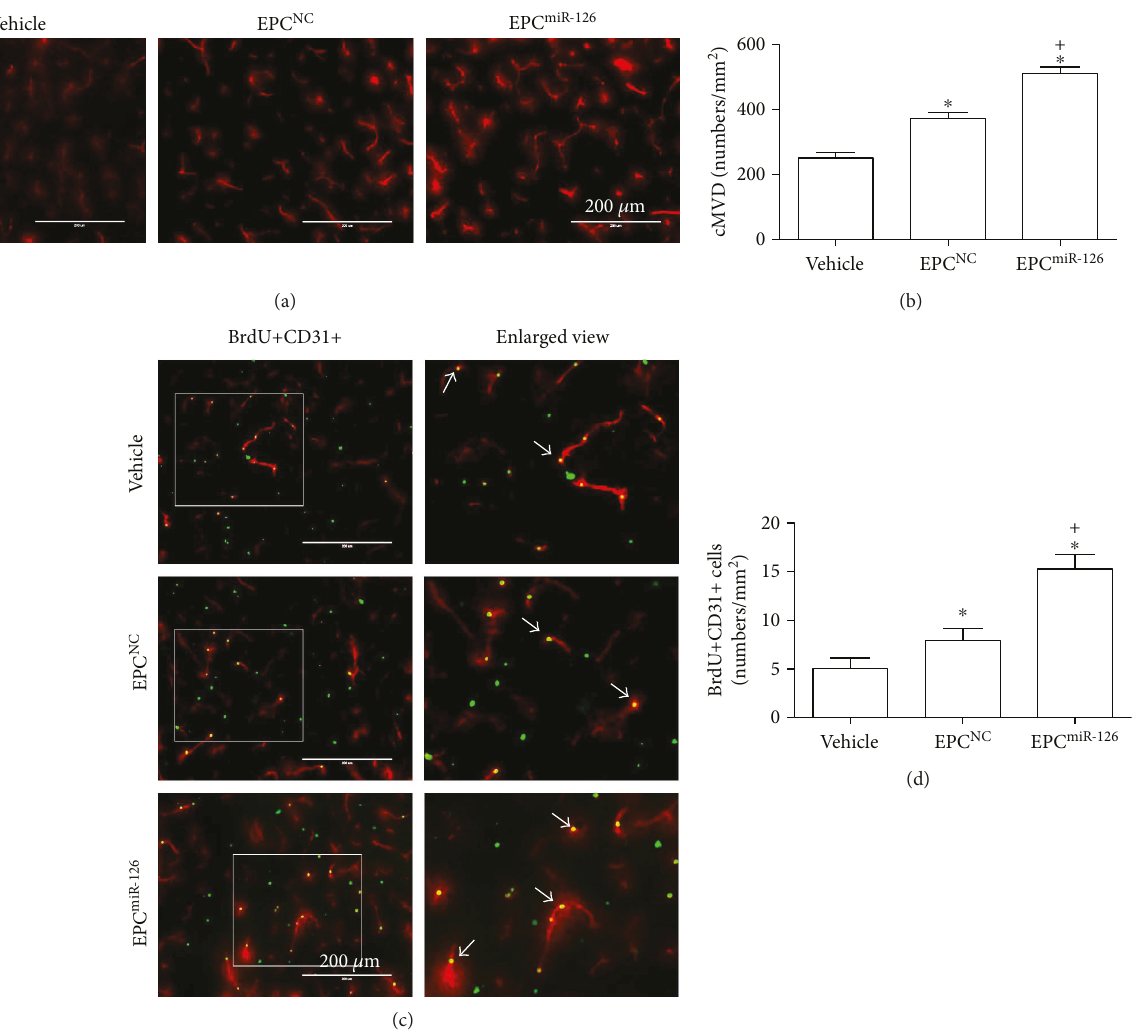
Figure 6: miR-126 priming enhances the e ffi cacy of EPCs in increasing cMVD and angiogenesis in the peri-infarct area of MCAO mice. (a) Representative pictures of cMVD (CD31 immunostaining). Scale bar: 200 μ m. (b) Summarized data of cMVD. (c) Representative pictures of angiogenesis (BrdU+CD31+ cells). Red, CD31 for vessel; green, BrdU for new generated cells; pink, double staining. Scale bar, 200 μ m. The enlarged view of double-staining cells is in the left panel of each image. The arrows indicate the double staining cells. (d) Histogram showing the number of BrdU+CD31+ cells. ∗ p < 0 05 versus vehicle; + p < 0 05 versus EPC NC , n = 10